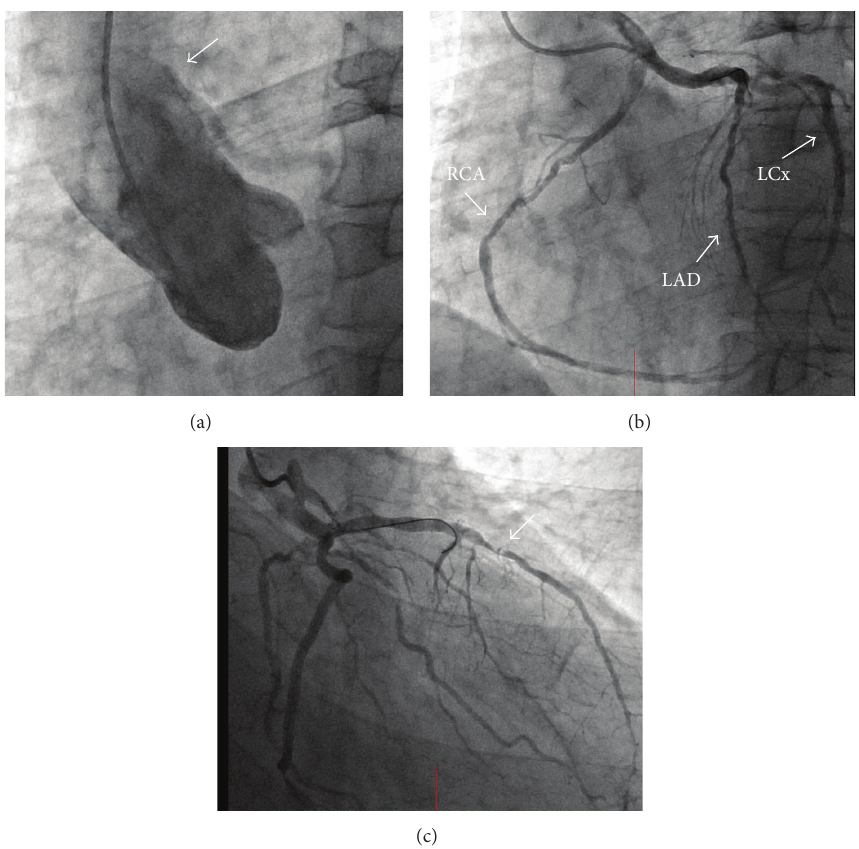
Figure 1: (a) Aortography with a pigtail catheter showing the anomalous origin of the coronary artery from the ascending aorta. (b) Coronary artery angiography with 5-Fr Amplatz Left-1 (AL-1) diagnostic catheter showing the single coronary trunk. (c) Right anterior oblique view showing critical stenosis in the middle segment of the left anterior descending (LAD) artery. A 0.014-inch guide wire was advanced into the LAD in order to stabilize the diagnostic